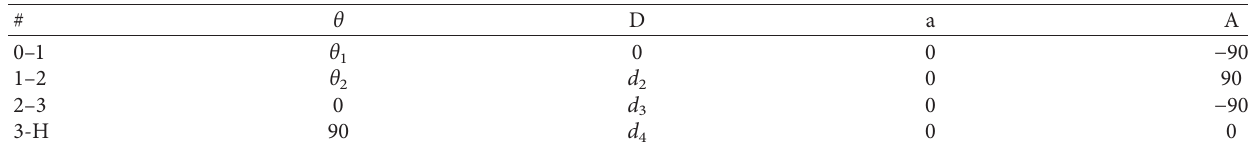
Table 1: D-H parameter table.